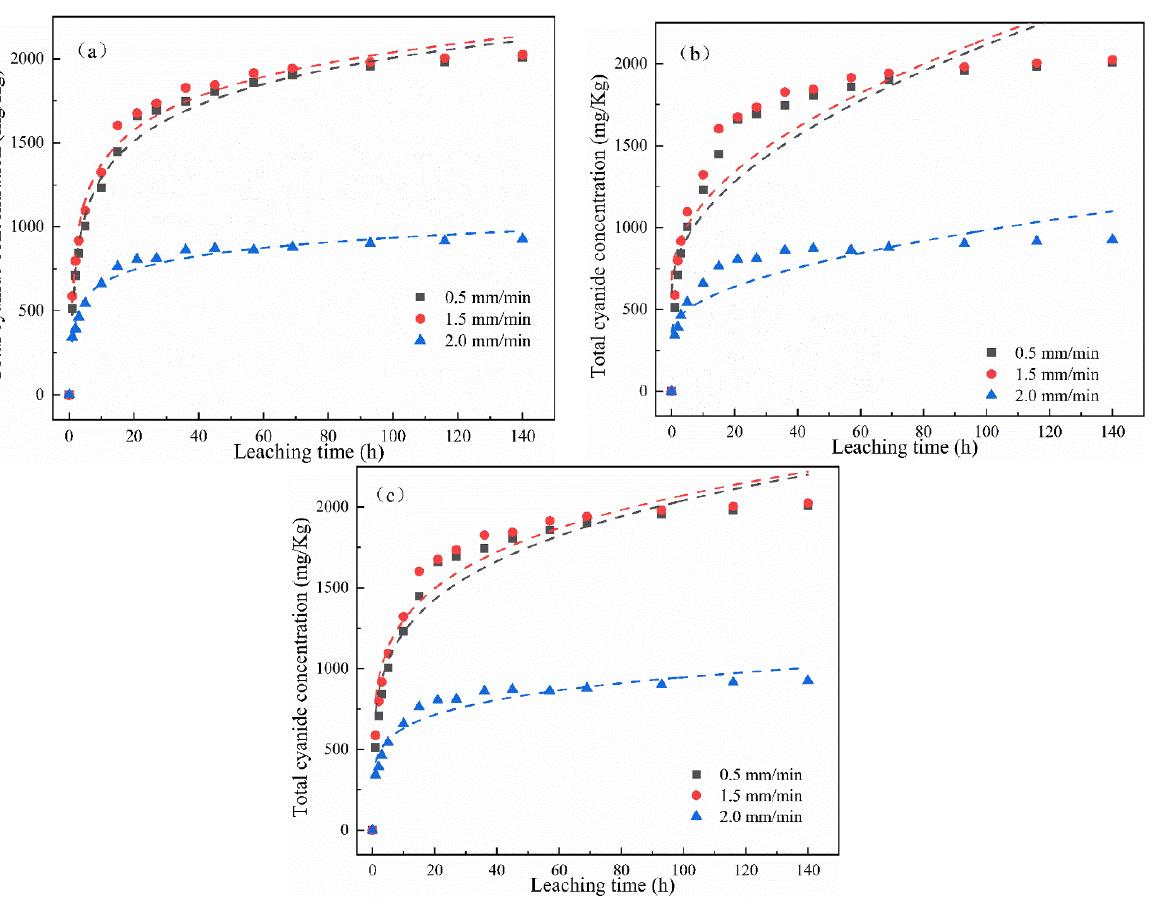
Figure 7. Nonlinear fitting using ( a ) Elovich, ( b ) parabolic diffusion, and ( c ) double constant equations of total cyanide cumulative release over time under different leaching intensity.